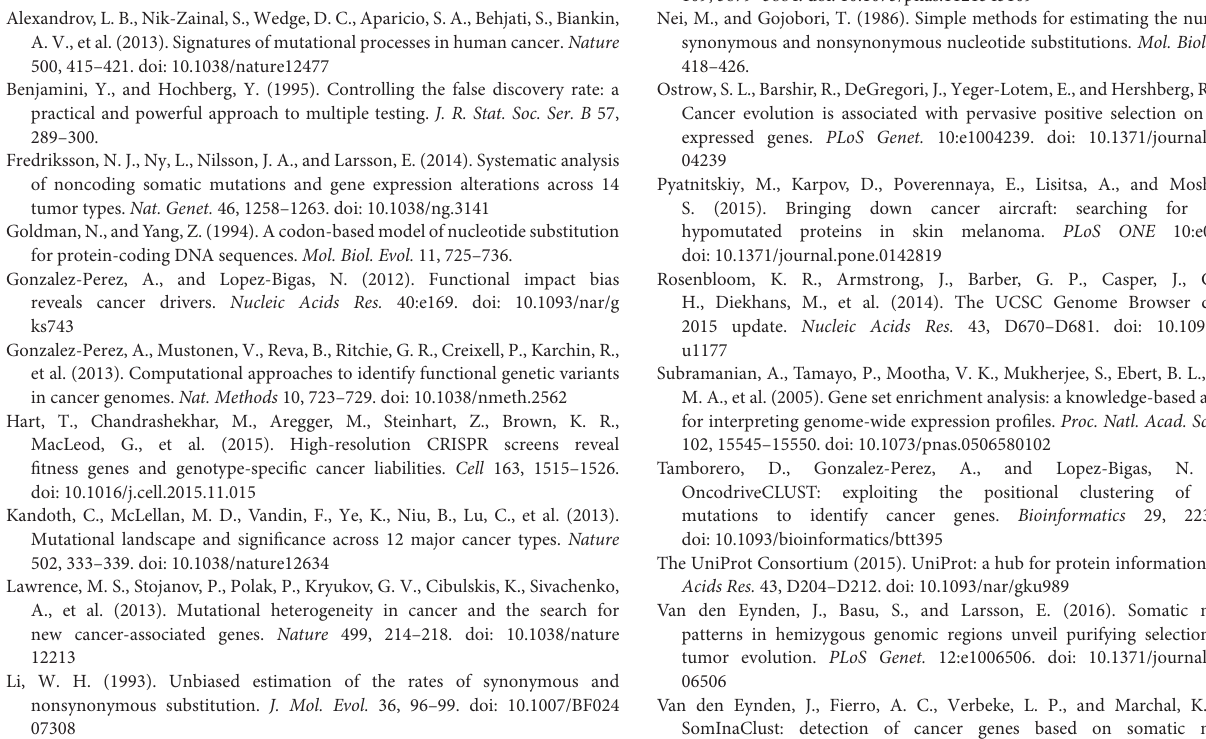
Table S5 | GO cellular components gene set enrichment results on genes with low simulated dN/dS values. A gene set enrichment analysis for GO cellular components was performed for the genes that had simulated dN/dS values below 0.35. Simulations were performed using the 6-class and the 96-class malignant melanoma signature, respectively (indicated by tab names). Cellular components are ranked based on increasing enrichment p- values. Table S6 | GO cellular components gene set enrichment results for genes with low observed corrected dN/dS values. A gene set enrichment analysis for GO cellular components was performed on each cancer type (indicated by tab names) for the 100 genes with lowest p- values. Cellular components are ranked based on increasing enrichment p- values. Figure S1 | Comparison of simulated dN/dS values between cancer types. The ratio dN/dS was simulated based on mutation probabilities derived from the 6-substitution (A) or 96-substitution (B) class model. Figure S2 | 96-class mutational signatures for different cancer types. Bars indicate the percentage of each of 96 mutation types, determined by the substitution class and the adjacent up- and downstream nucleotide. Cancer type is indicated above every chart. Figure S3 | Comparison of mutational signatures derived from whole exome- (WES) and whole genome sequencing (WGS) data in malignant melanoma. (A) Comparison of the 96-class mutational signatures derived from 345 WES malignant melanoma samples (upper panel), the exonic (middle panel), and non-exonic (lower panel) genomic regions from 38 WGS malignant melanoma samples. Bars indicate the percentage of each of 96 mutation types, determined by the substitution class and the adjacent up- and downstream nucleotide. (B) Comparison of dN/dS values after correction using mutational probabilities derived from different data sources as